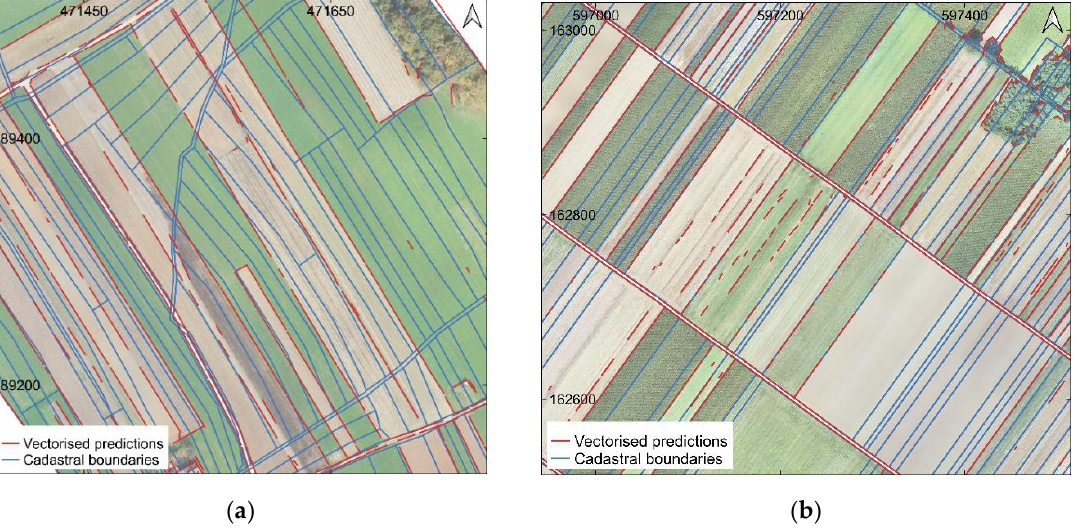
Figure 11. Vectorised predictions overlaid with cadastral boundaries: ( a ) discrepancy map for Ponova vas; ( b ) discrepancy map for Odranci.